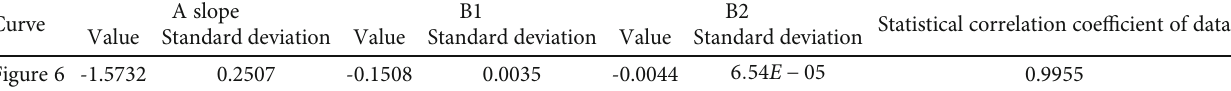
Table 4: According to the fi tting parameters of Figure 5.